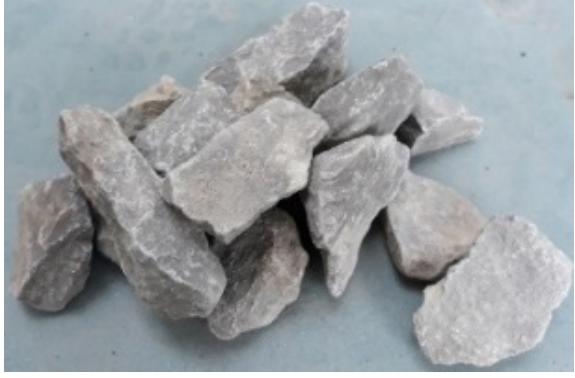
Figure 9: An example of the specimen prepared for laboratory tests